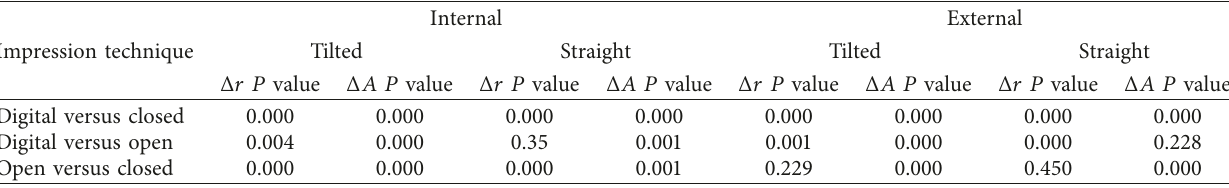
Table 3: The effect of the impression technique by comparing inaccuracy values for each group at the implant angulation and connection type.